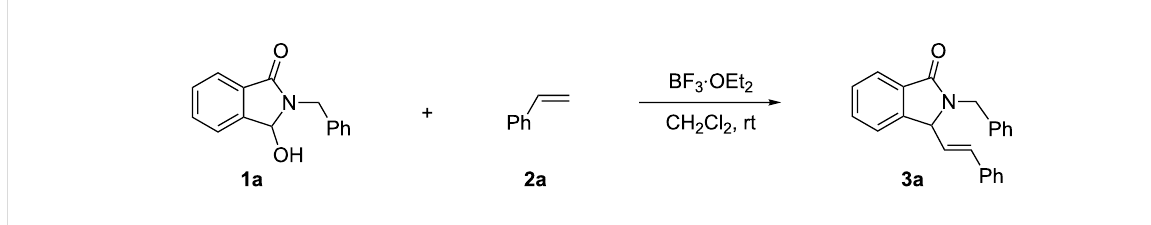
Scheme 1: Reaction of 3-hydroxyisoindol-1-one with styrene.